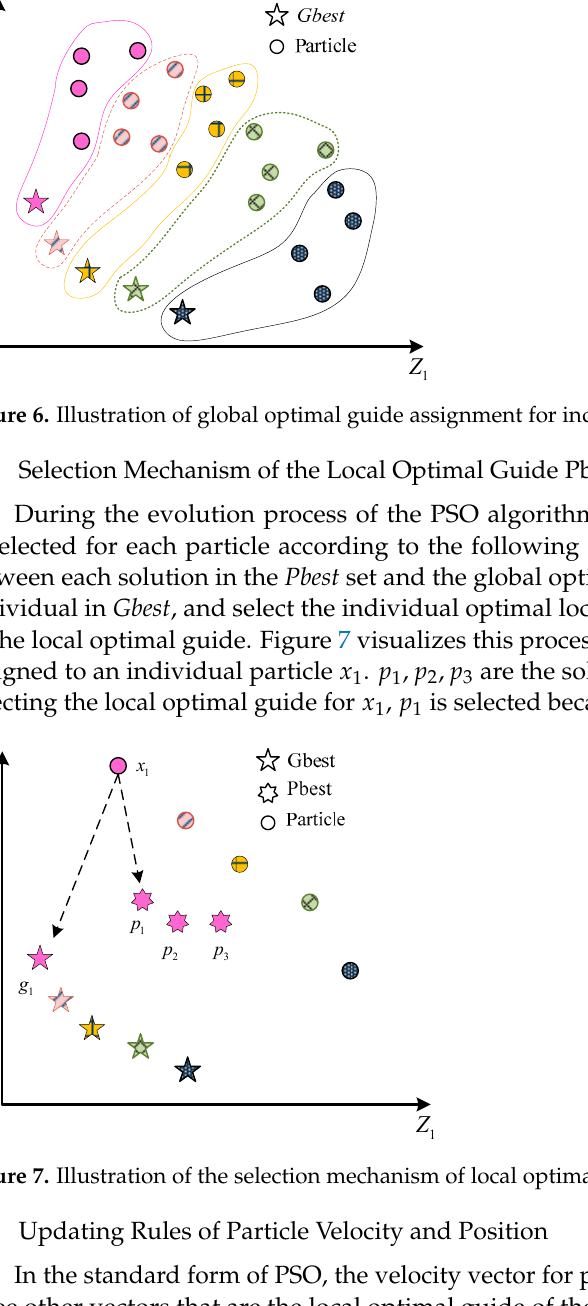
Figure 7. Illustration of the selection mechanism of local optimal guide.